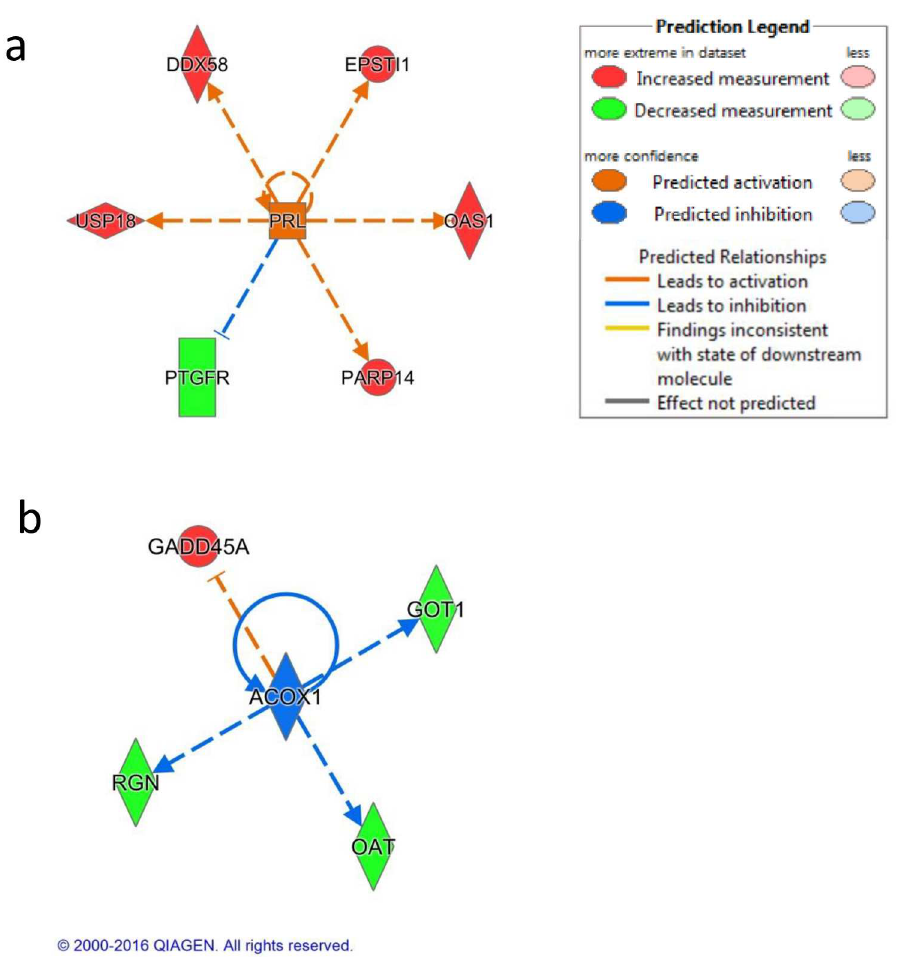
Fig 3. Upstreamregulators with corresponding activation or inhibition predicted by IPA ® . Upstream regulatorsand their targets displayedas a network of interactions with their respectiveexpressiontrends. Node shapes represent functionalclasses; vertically rectangle for G-protein coupledreceptor, squaresfor cytokines, vertically diamonds for enzymes, horizontallydiamonds for peptidase, and circles for other. (a) PRL (predictedas activated), (b) ACOX1 (predictedas